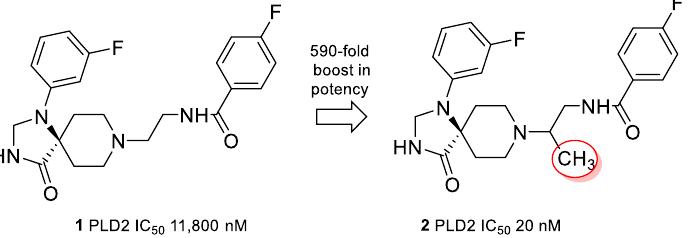
Figure 1. Example of CH methylation where a magic methyl effect was observed.